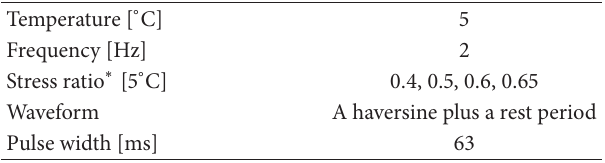
Table 4: Detailed parameters used in the mixture fatigue test.